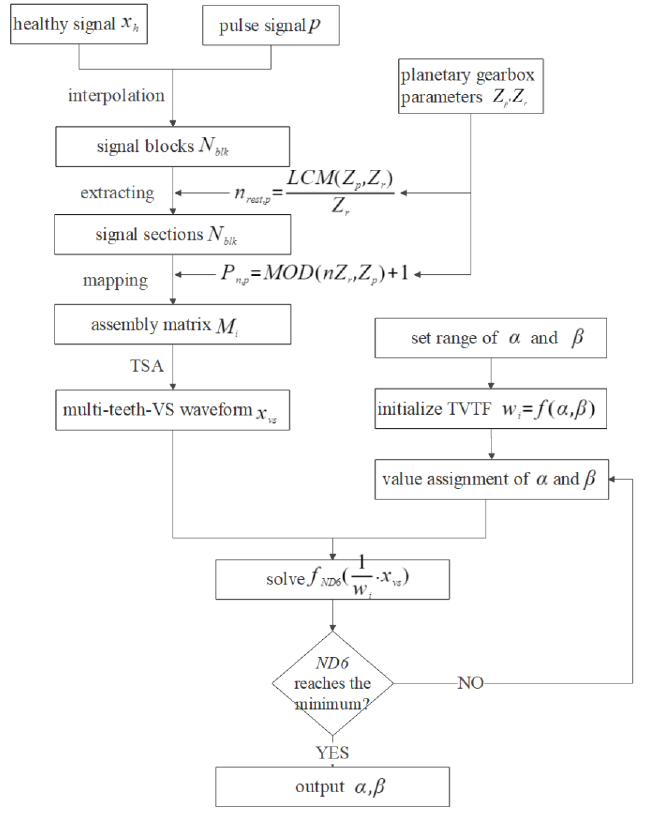
Figure 4. Flow chart of construction of the